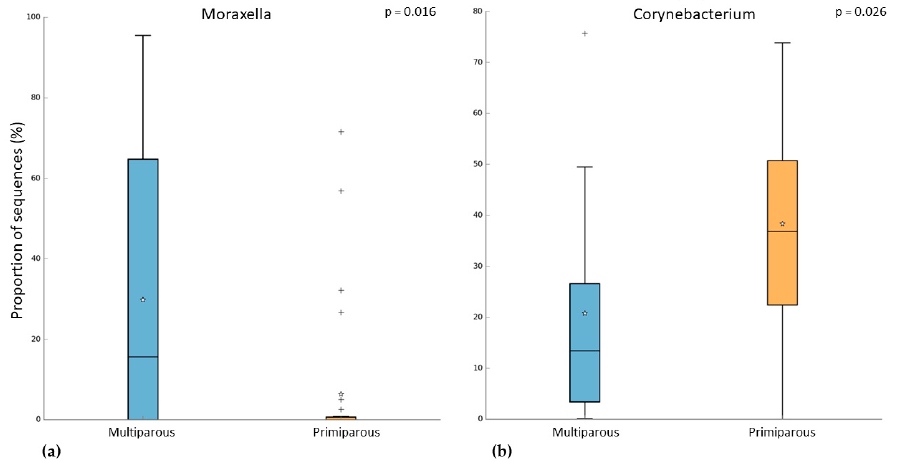
Figure 4. Difference between multiparous and primiparous pregnant women in the relative abundance of ( a ) Moraxella and ( b ) Corynebacterium. “+” indicate the outliers; “stars” indicate the mean value.